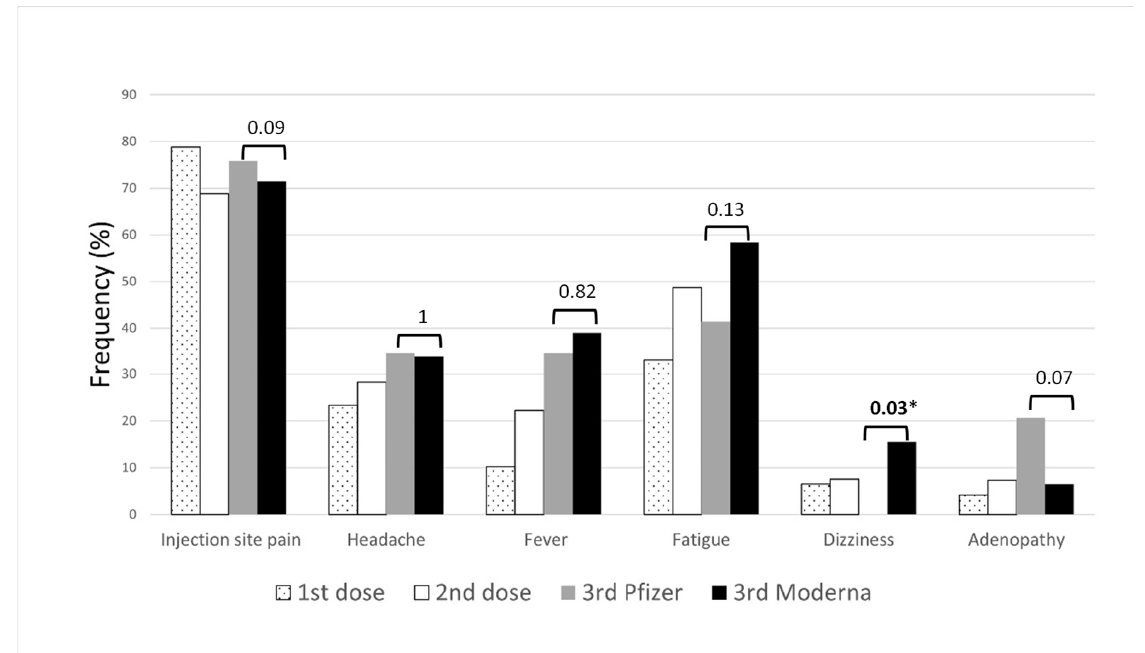
Figure 1. Adverse effects among people vaccinated with a double dose of Pfizer. bars represent p -values. * p -values < 0.05.